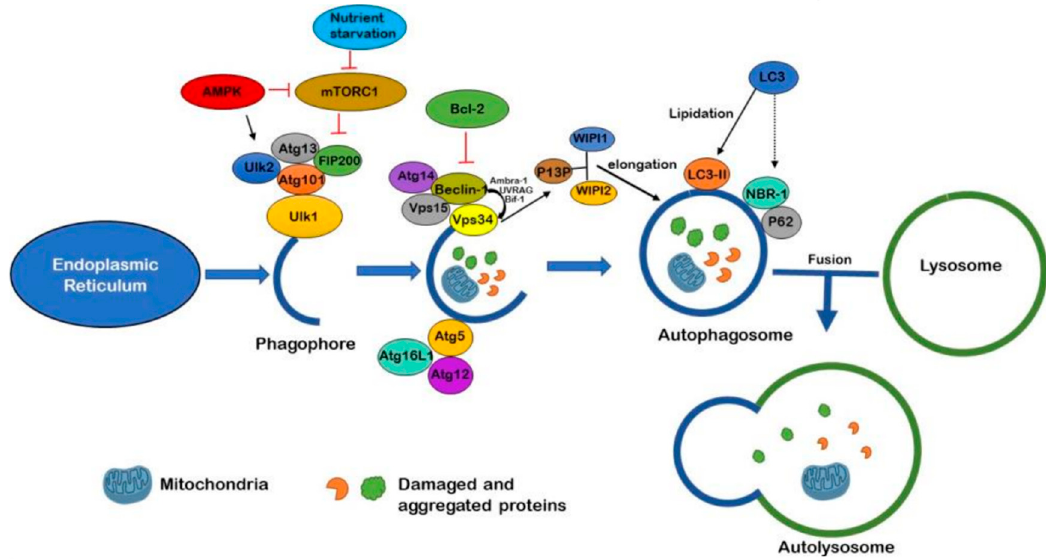
Figure 1. Regulation of autophagy mediated degradation: Autophagosome formation begins when phagophore is produced from ER initiated by either AMPK activation or mTOR inhibition by nutrient starvation. Once autophagosome formation is initiated, the ULK1 complex (composed of Atg13, Ulk2, Atg101 and Fip200) is phosphorylated. Vps4 complex is positively regulated and the developing phagophore elongates. Beclin-1 together with Ambra-1, Bif-1 and UVRAG activate Vps34, generates P13P—which then facilitates Atg16L1-Atg5-Atg12 recruitment. Beclin-1 mediated autophagosome generation can be inhibited by Bcl-2. P13P binds with WIPI1 and WIP2 and promotes phagophore elongation. LC3-I is lipidated to form LC3-II. LC3 additionally anchors adaptor proteins p62 and NBR-1 onto the phagophore for substrate targeting, and phagophore closes to become an autophagosome. Fusion of autophagosome and lysosome create the autolysosome, which digests the substrates and recycles back into the cytoplasm.